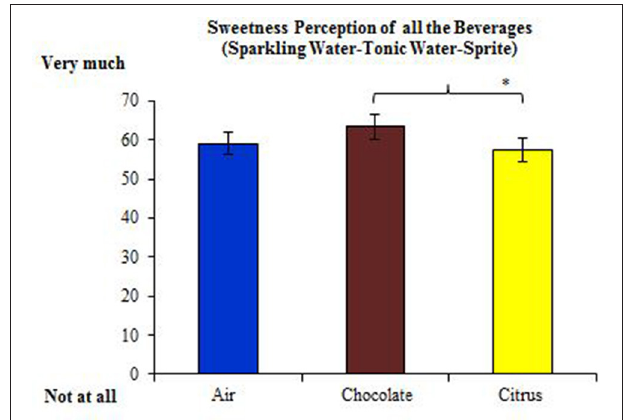
FIGURE 6 | The participants’ mean judgments of sweetness for all the beverages tasted regardless of the evaluation sequence, as a function of the different odor conditions and. Error bars represent the standard errors of the means. Asterisks represent Newman-Keuls significant differences at * p < 0.01.